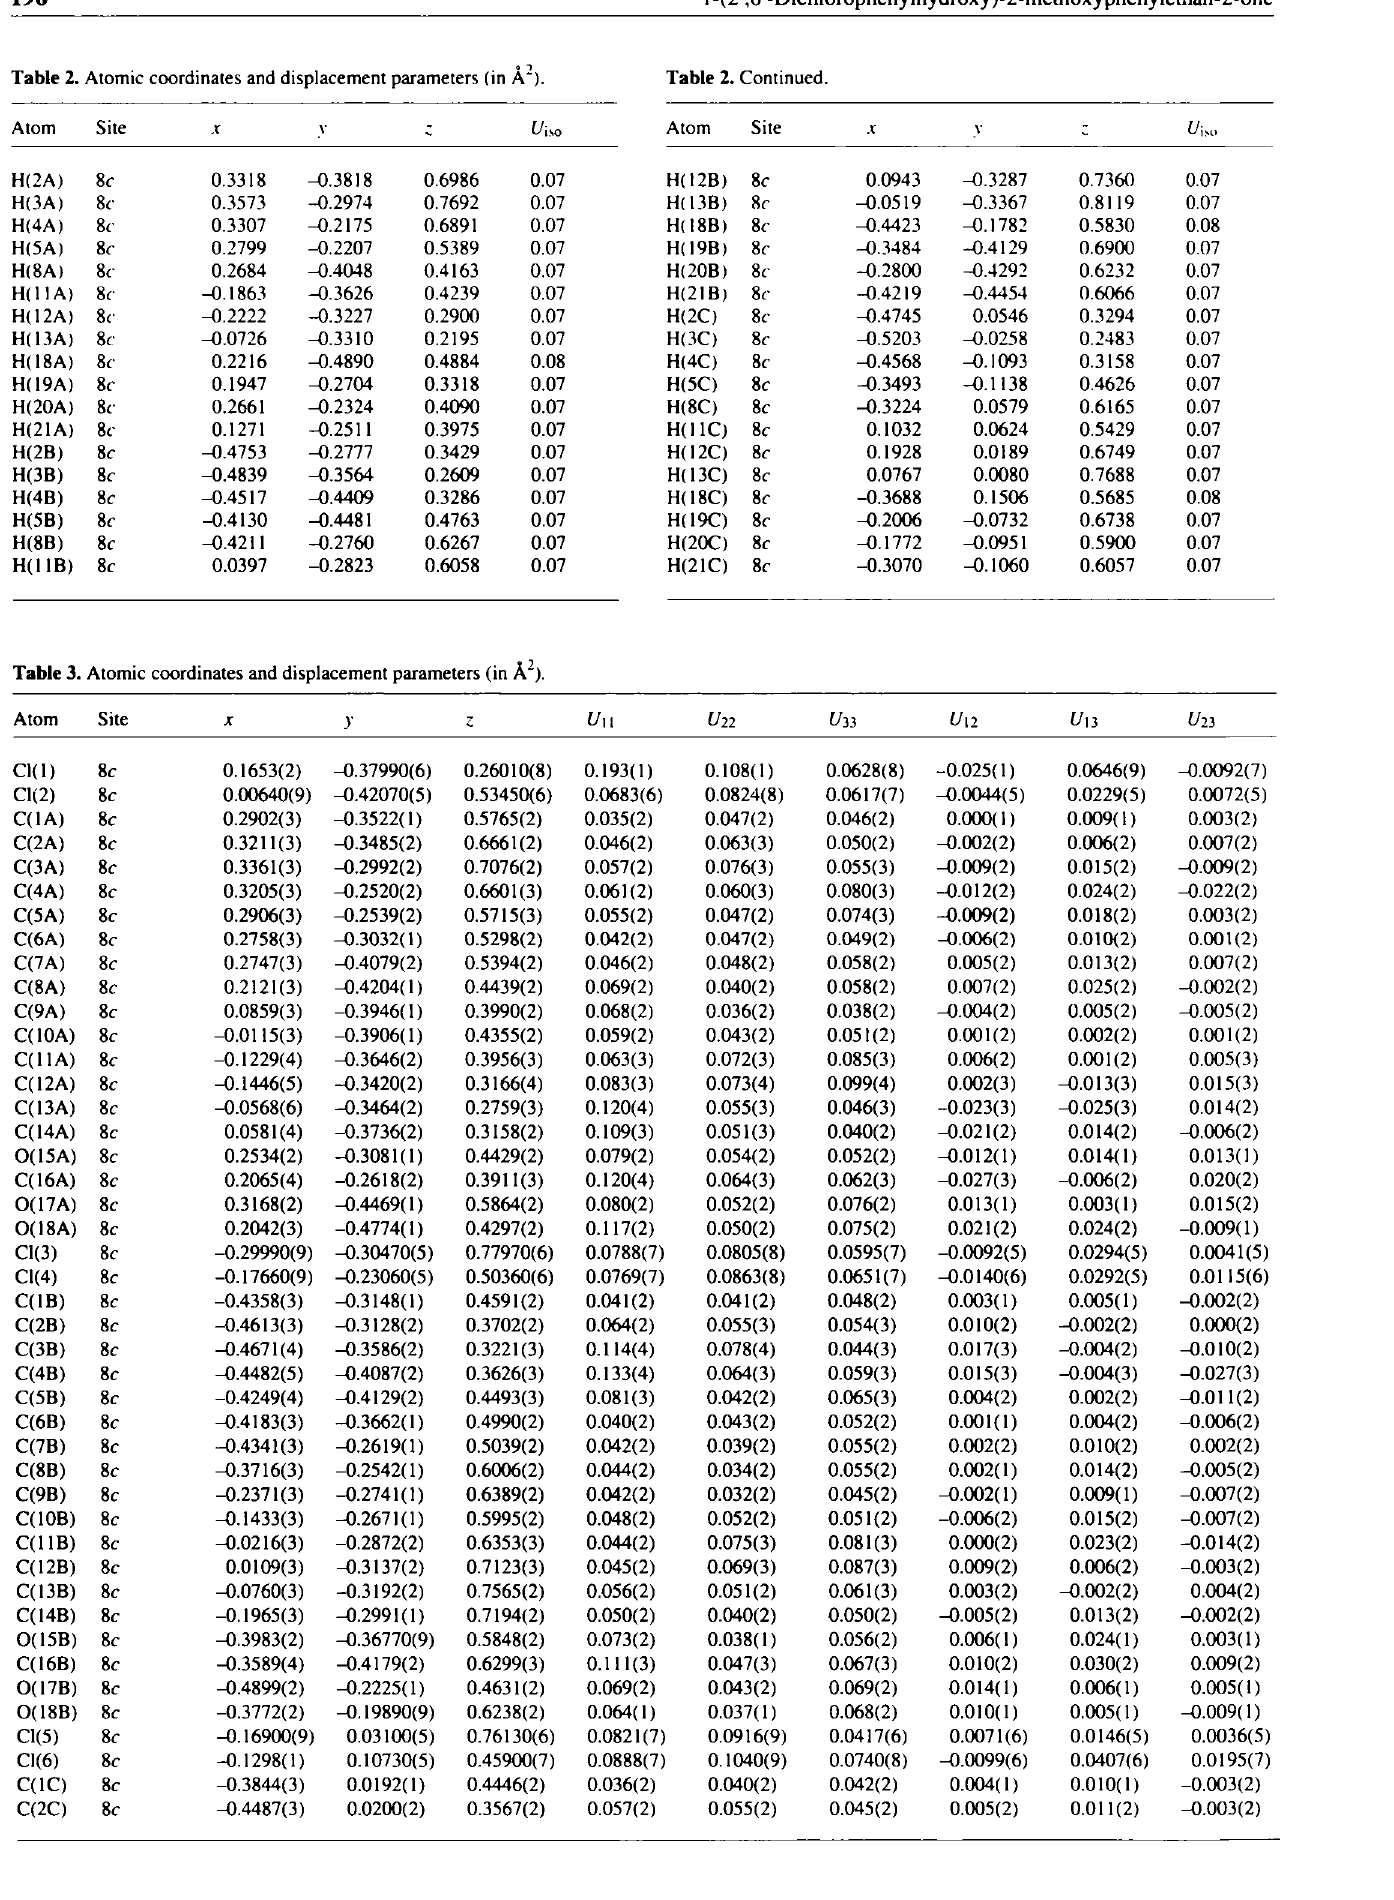
Table 3. Atomic coordinates and displacement parameters (in Ä 2